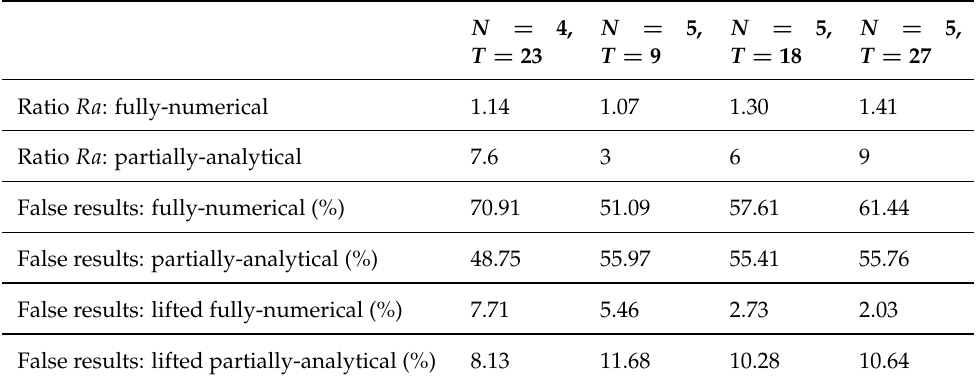
Table 5. The UWB self-calibration results are based on a 2D model with synthetic data. The identified false optimizations have an error larger than